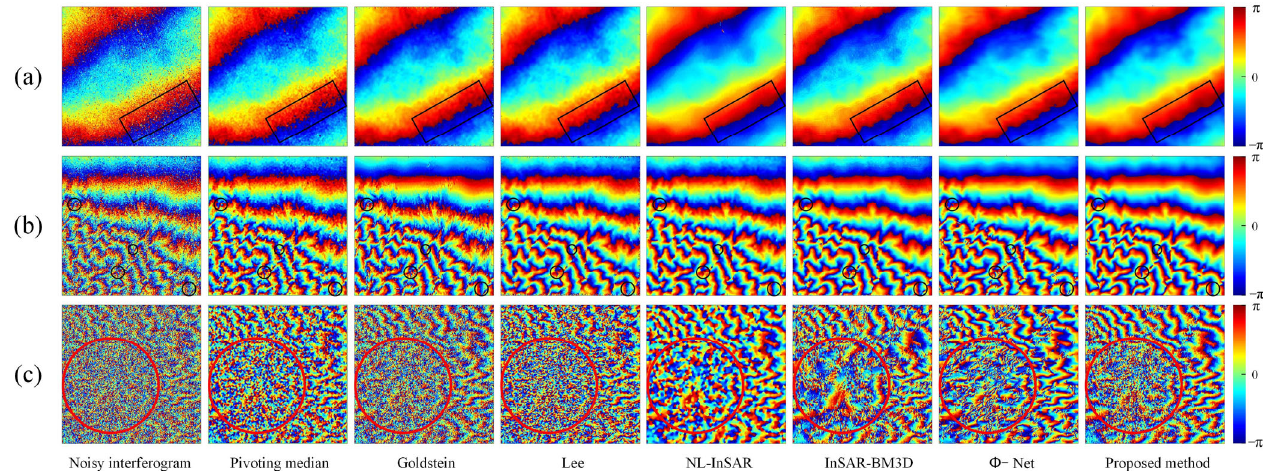
Figure 9. The noisy interferograms and filtered images of real data ( a – c ) from Figure 8. ( a ) Flat terrain, ( b ) Steep terrain, ( c ) Areas with high vegetation coverage. ( b ) Steep terrain, ( c ) Areas with high vegetation